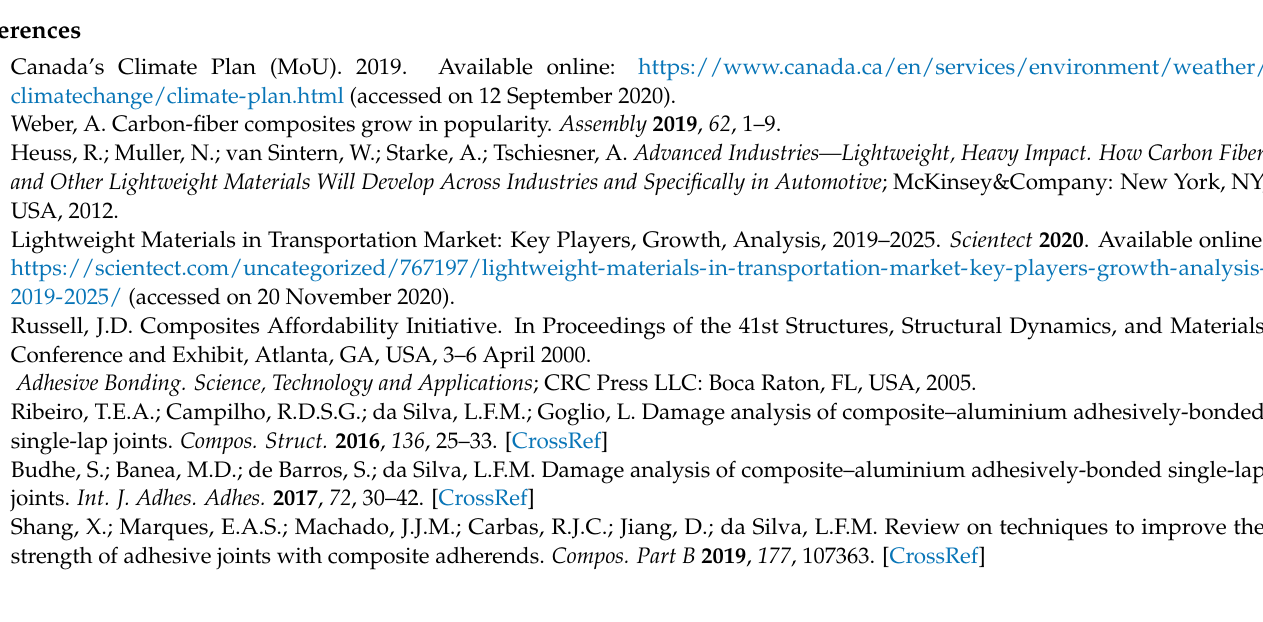
Figure A2. Schematic of the double cantilever beam adhesive joints comprising CFRPs adherents and bonded with an epoxy adhesive. Dimensions are not to scale. Notice that the thickness of the blocks was H = 30 mm, and the width was a match with that of the substrates. The initiation fracture toughness obtained from the mode I precrack can be determined using the following approaches: (i) NL, i.e., onset of nonlinearity on the load-displacement curve; (ii) VIS, i.e., onset of a visually recognizable crack increment as observed from the edge of the specimen; (iii) MAX/5%, i.e., the point of intersection of a straight line with the P- δ curve, with the slope of the straight line 5% higher than the initial